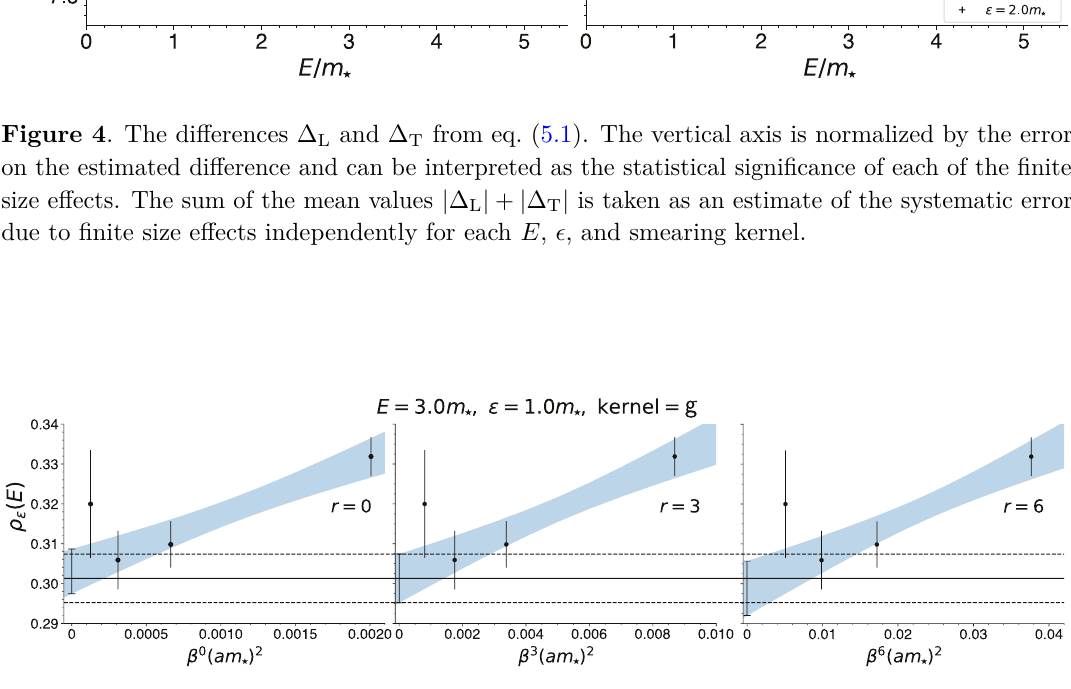
Figure 5 . Illustration of the continuum extrapolation procedure from eq. (4.7) with r = 0 , 3 , and 6 at E = 3 m ? , (cid:15) = m ? , and the Gaussian smearing kernel. The three panels show the r = 0 ansatz (left), the r = 3 (center), and the r = 6 (right). The points at a = 0 are the continuum extrapolated values and the horizontal band is the extrapolated value from β 3 a 2 , which is taken as the best estimate. As in figure 1, there is evidently little variation across the different extrapolation